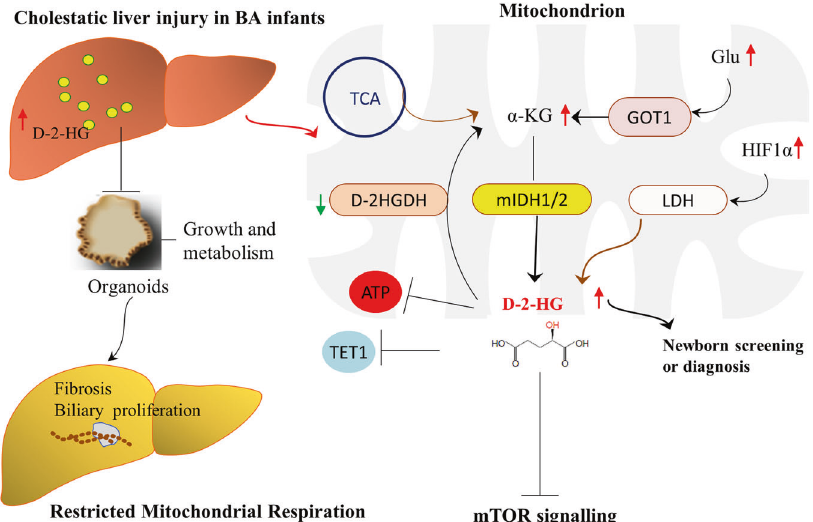
Fig. 8 Schematic diagram of potential mechanisms that D-2-HG involved in liver regeneration in BA patients. Biliary atresia is incurable and needs liver transplantation. Using targeted metabolomics, we unexpectedly identi fi ed a metabolite 2-hydroxyglutarate (2-HG) that has great potential in diagnosis or newborn screening. By using ‘ mini organs of liver ’ in vitro and a zebra fi sh model in vivo, we demonstrate D-2- HG accumulates in the liver and alters the hepatic microenvironment, and subsequently impairs liver regeneration via reducing the mitochondrial respiration and ATP synthase. Our fi ndings reveal D-2-HG has a novel pathogenic mechanism that could have important diagnostic and therapeutic